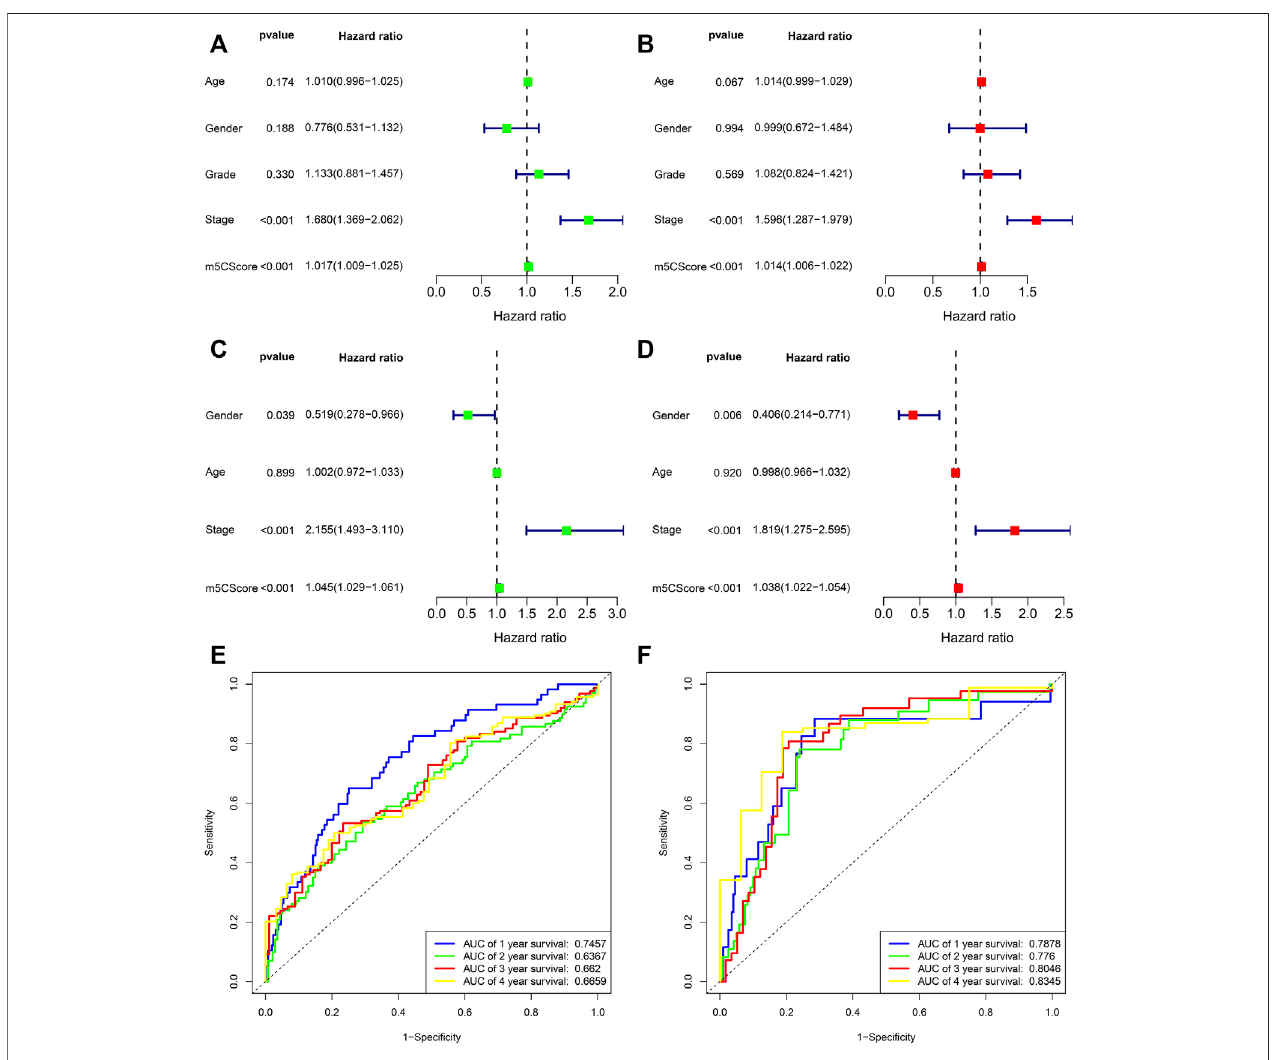
FIGURE 7 | Prognostic value of the m5Cscore model. (A) Univariate independent prognostic analysis in TCGA cohort; (B) Multivariate independent prognostic analysis in TCGA cohort; (C) Univariate independent prognostic analysis in ICGC cohort; (D) Multivariate independent prognostic analysis in ICGC cohort; (E) Receiver operating characteristic (ROC) curves of m5Cscore for predicting the 1/2/3/4/5-years survival in TCGA cohort; (F) Receiver operating characteristic (ROC) curves of m5Cscore for predicting the 1/2/3/4/5-years survival in ICGC cohort.